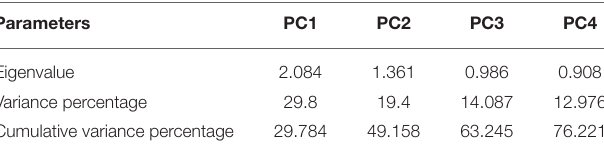
TABLE 3 | Principal component analysis of quantitative traits of 64 Daucus carota L. genotypes. Parameters